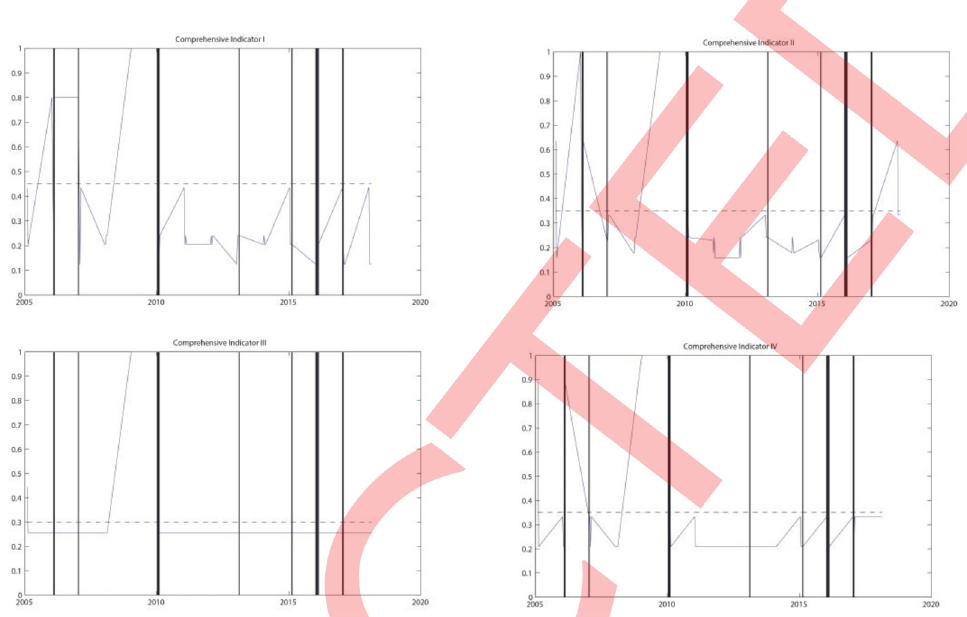
Fig 2. Probability forecasts of housing price crises for Beijing. The shaded regions represent the time spans of housing price crises. The solid lines are the forecasted probabilities from the four comprehensive indicators with the threshold level of k = 1. Correspondingly, the dashed lines are their cut-off probabilities.